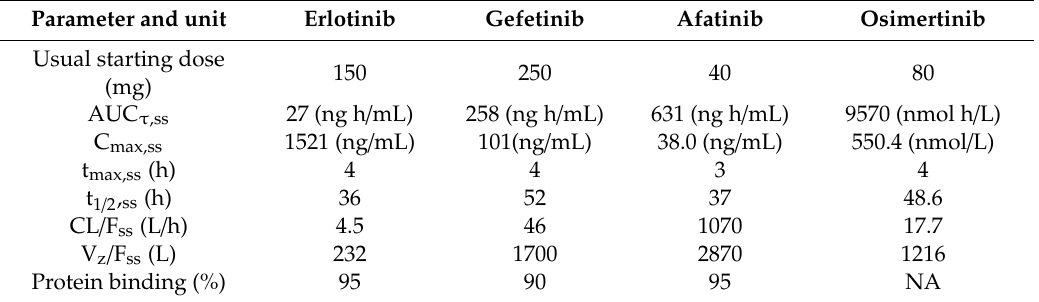
Table 1. Summary of steady-state pharmacokinetics of 4 TKI after multiple once daily oral doses. Parameter and